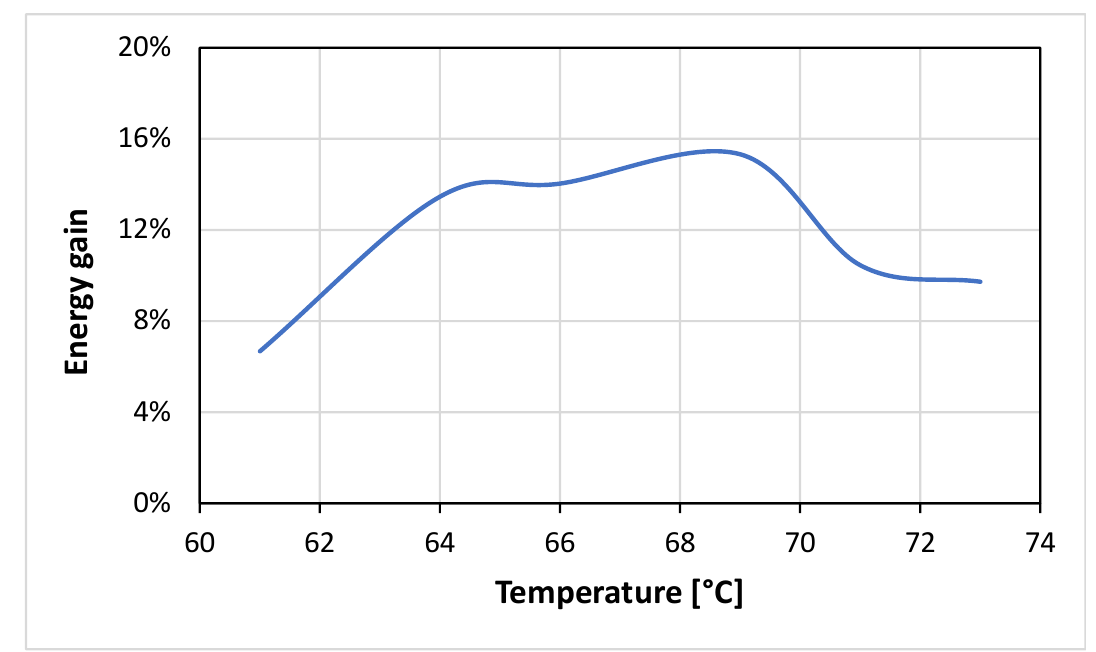
Figure 11. Energy gain derived from the use of the hybrid tank instead of the sensible one. The economic benefits arising from the use of the TES system are quantified on the basis of the energy gain in accordance with the Italian national unit price for energy (PUN) [37], which is the reference value for the Italian energy market. This does not consider specific discounts or rates from the various utilities and operators, but it was considered the fairest means of comparison. For December 2022, the cost of energy was 0.294 EUR/kWh.